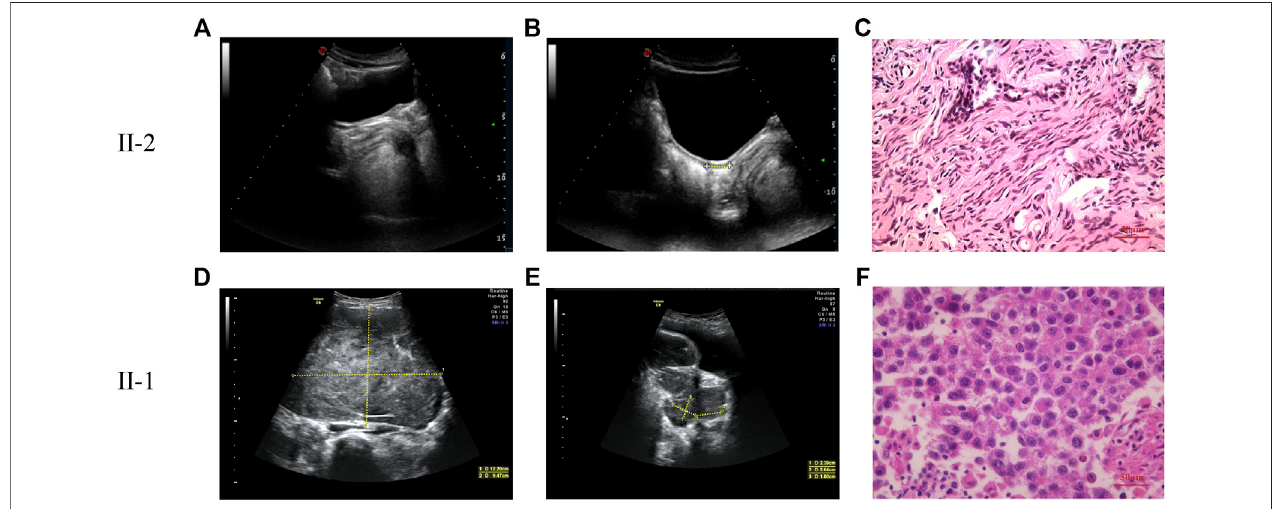
FIGURE 1 | The pelvic ultrasound and pathological images of patients. (A,B) The pelvic ultrasound of proband (II-2). Yellow dashed lines indicate the length of ultrasonography. (A) Noidenti fi abletesticularorovariantissuewasobservedinthepelvicultrasound. (B) Underdevelopeduterus(1.5×0.5×1.0 cm)oftheproband. (C) Pathological section analysis of proband (HE, ×40). Pathological evaluation reveals that the bilateral streak gonads are ovarian interstitial-like cells and germinal epithelium, without any malignanttransformation. (D,E) The pelvic ultrasound of patient 2 (II-1). Yellow dashed lines indicate the length ofultrasonography. (D) Left ovarian mass (12.2 × 9.5 × 7.0 cm). (E) Right ovarian mass (2.3 × 2.6 × 1.8 cm). (F) Pathological section analysis of patient II-1 (HE, ×40). The pathological evaluation identi fi ed the bilateral ovarian tumors as dysgerminoma.